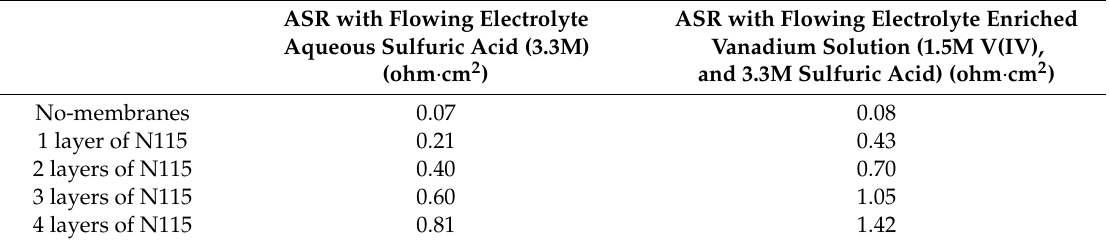
Table 1. Area-specific resistance (ASR) for series of Nafion ® 115 membranes.